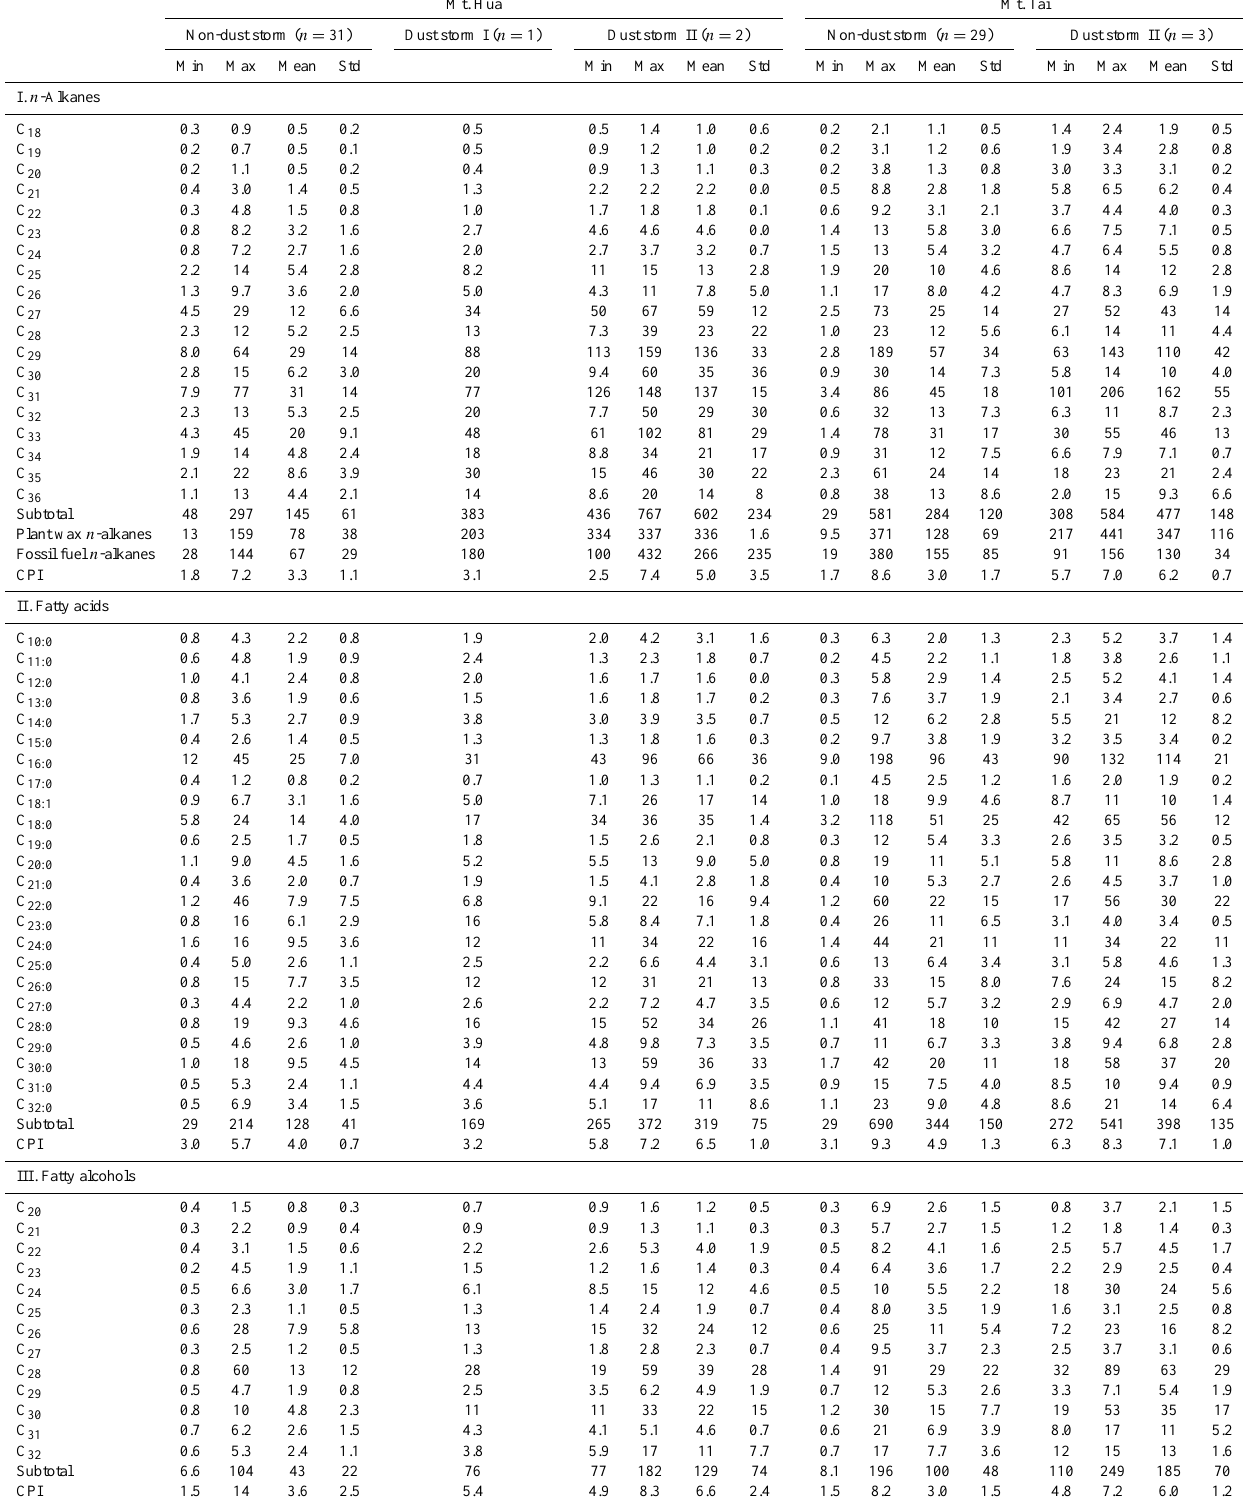
Table 1. Concentrations of organic compounds in PM 10 collected at the summits of Mt. Hua (2060 ma.s.l.) and Mt. Tai (1545 ma.s.l.) in central and east China during spring 2009 (ngm − 3 ) . Mt. Hua Mt.